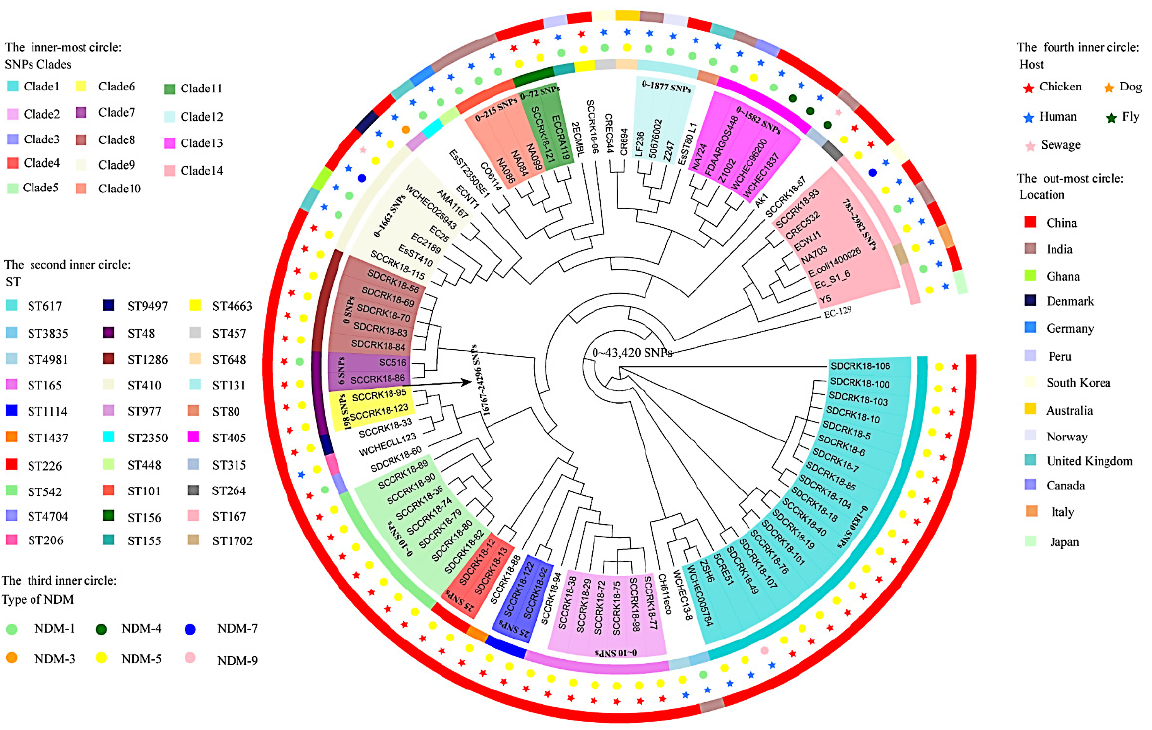
Figure 2. Core genome evolution relationship of the bla NDM gene carrying E. coli strains (50 strains from this study, 39 strains from the database). The genomic sequence of E. coli K-12 (accession number CP025268) was selected as a reference genome. The SNPs, STs, NDM, host, and country were indicated by different colors and shapes.